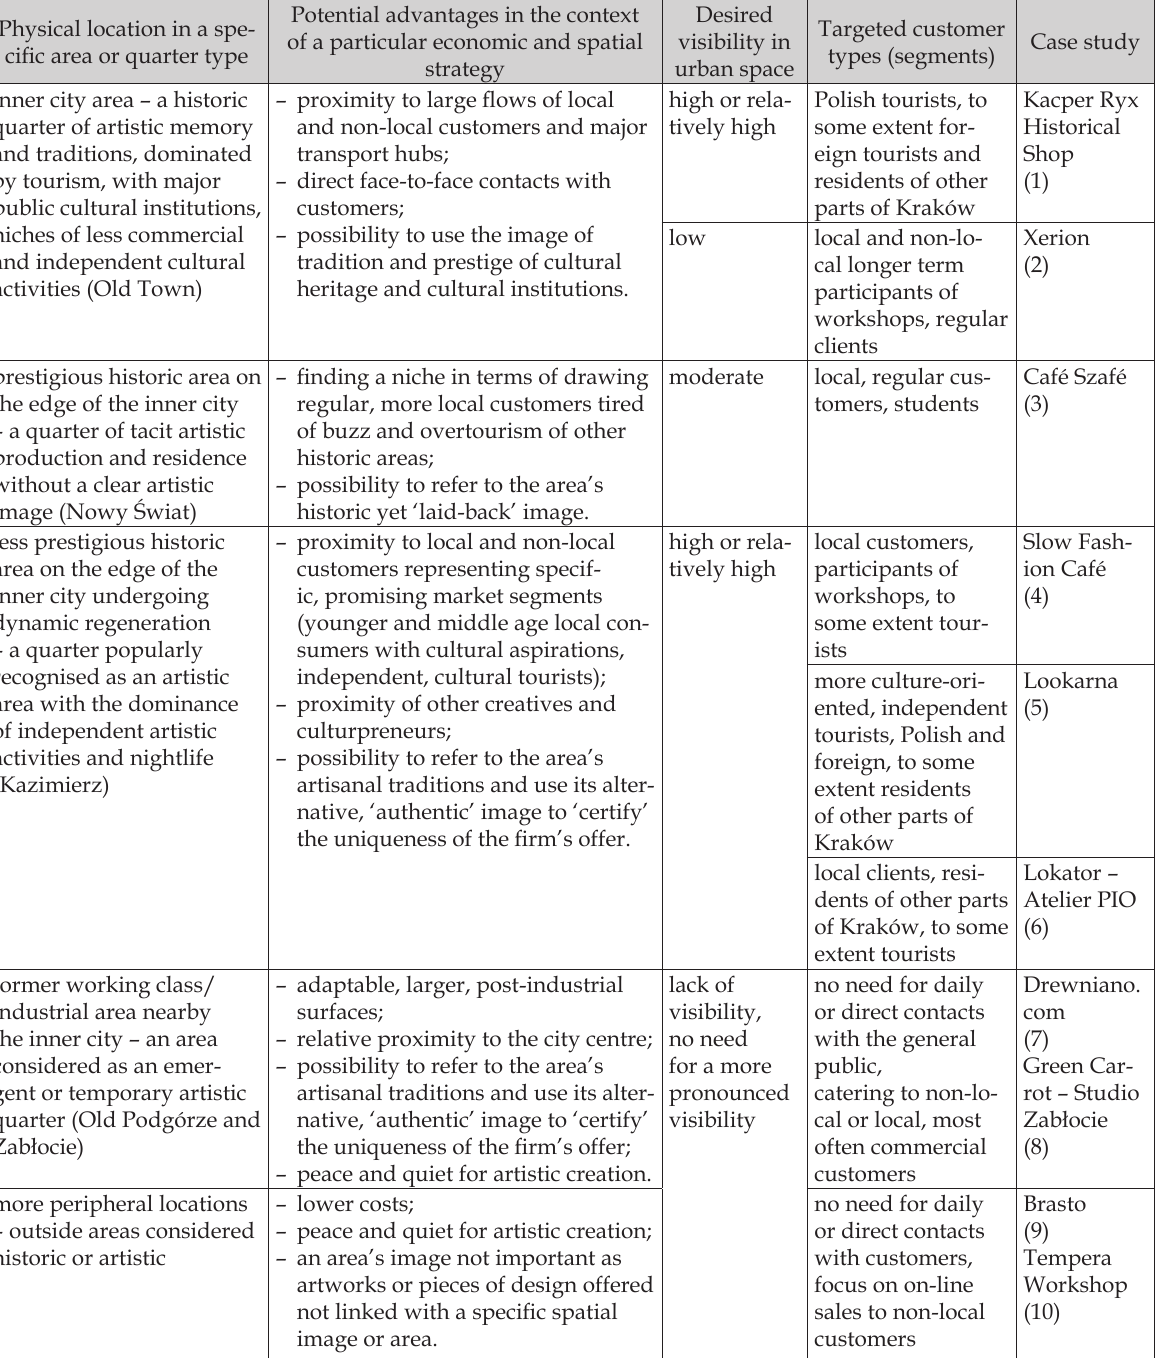
Table 1. Locations of artistic firms and their advantages in the context of economic and spatial strategies fol- lowed by particular artistic entrepreneurs in